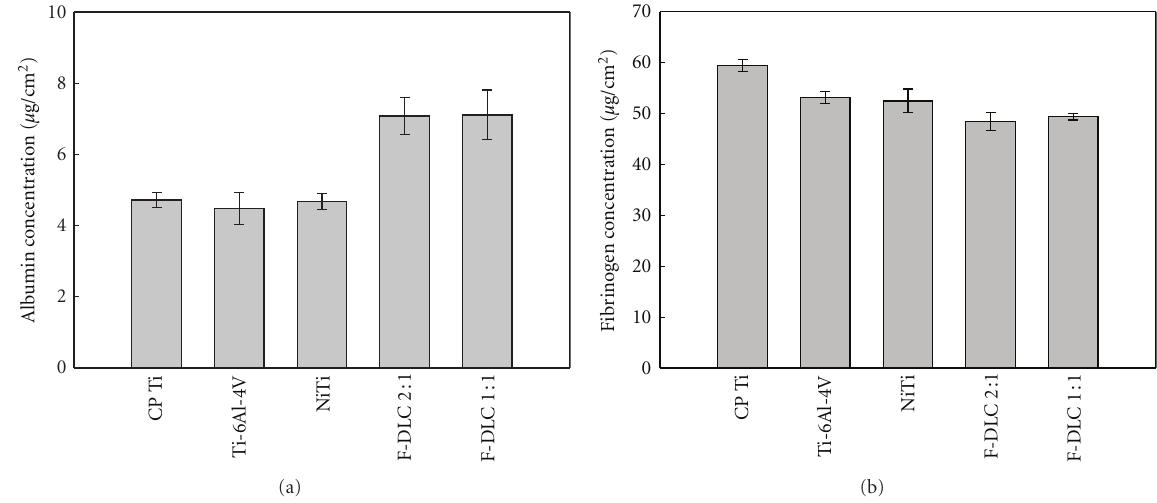
Figure 3: The adsorption of (a) albumin protein and (b) fibrinogen protein between Ti alloys and F-DLC films.